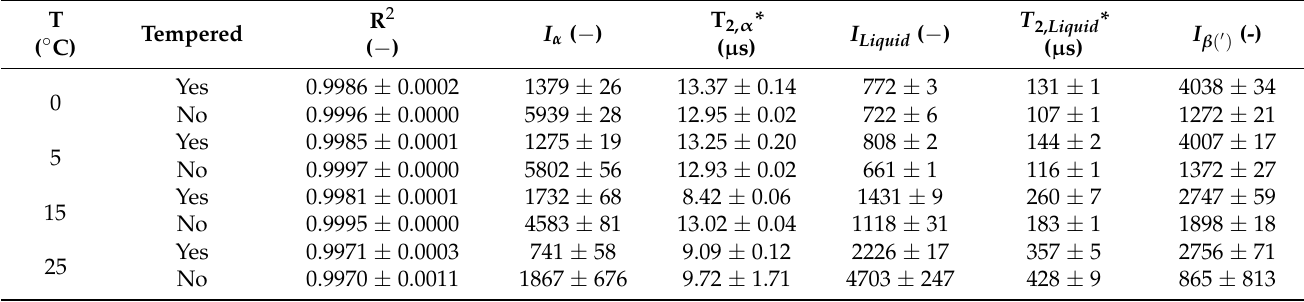
Table A3. Estimated parameter values of the fit of the Extended Abragamian model to the experimentally determined FID profiles of tempered and non-tempered cocoa butter at 0, 5, 15 and 25 ◦ C; the value of T ∗ 0.2 µ s − 1